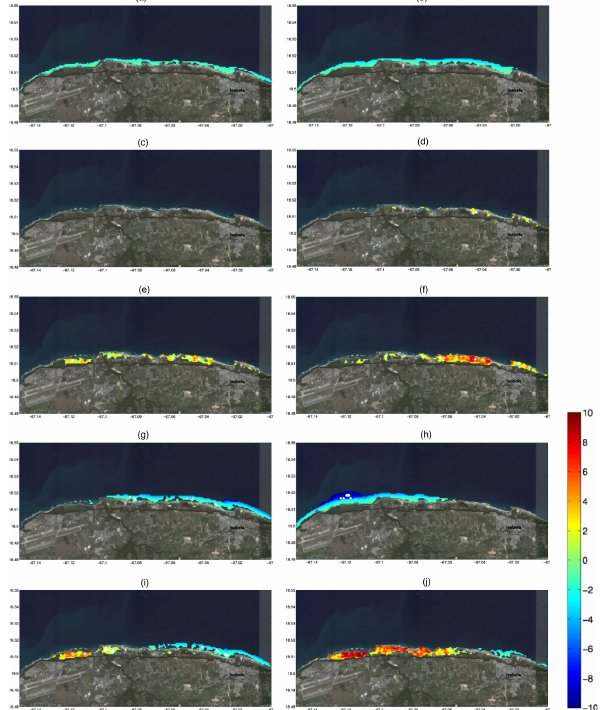
Fig. 13. Tsunami inundation in San Juan area on PRNS (Fig. 12a), in meters of ( > 0) elevation above ground, or ( < 0) dry bottom from water withdrawal, due to the M =9.1 co-seismic source (same case as in Figs. 6, 7, 11 in a fine grid). Time of plots: (a) 0, (b) 2, (c) 5, (d) 7, (e) 9, (f) 11, (g) 14, (h) 16, (i) 18, (j) 20min after the arrival of the tsunami onshore (about 350s after the event).